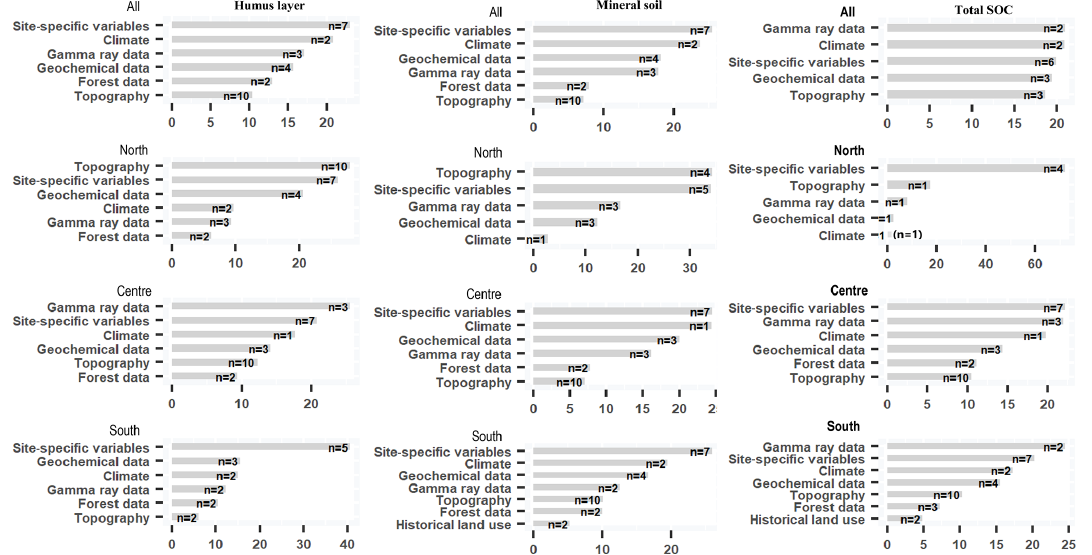
Figure 5. Variable importance of the main category of covariates for local and global random models for the humus layer, mineral soil, and total SOC